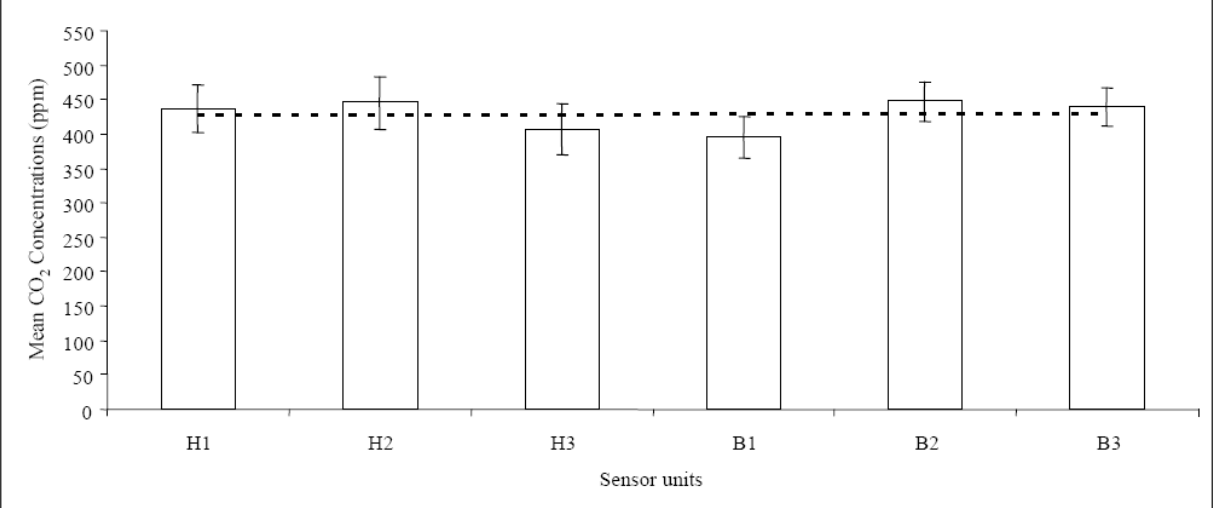
Figure 2. A comparison of relative performance of six sensor units for CO results compared in overall mean concentration levels of CO Dotted line represents the grand mean concentration derived from all six sensor units and whiskers represent the standard deviation values from the